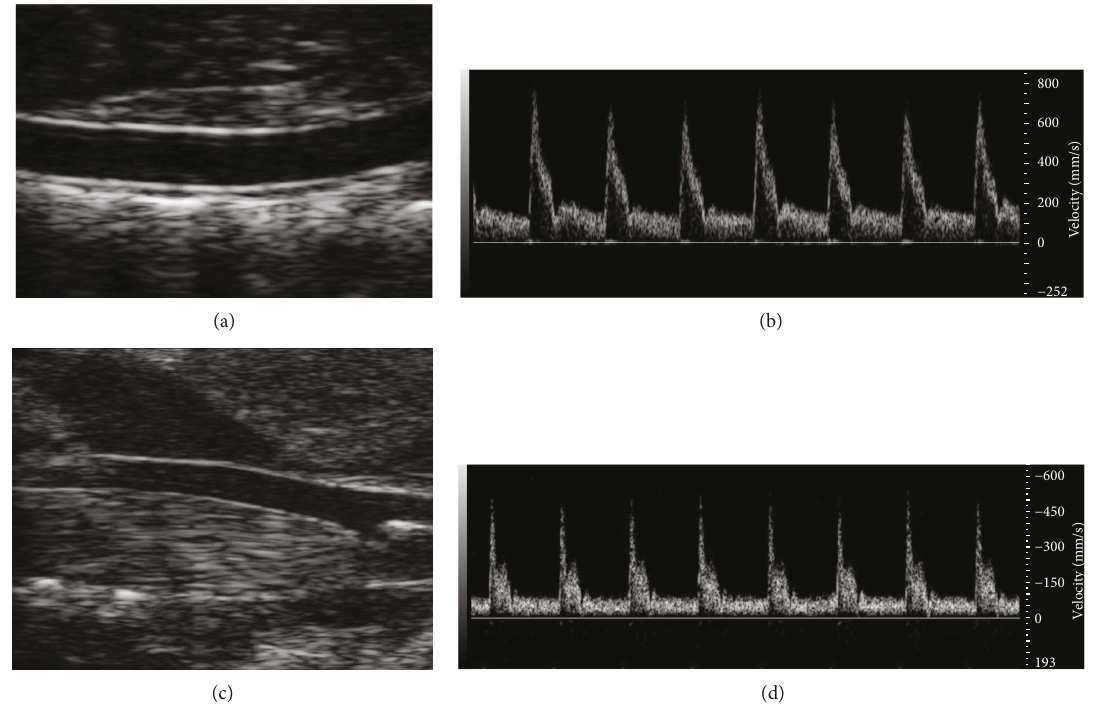
Figure 2: Abdominal aorta ultrasound scan. (a) B-mode image sequence was used to derived diameter and distension. (b) PW-Doppler signal was used to plot diameter- fl ow velocity loop thus evaluating PWV . Aortic pulse pressure was derived from PWV and distension abd abd measurements. Furthermore, blood fl ow velocity signal was used to derive wall shear rate measurements. Carotid artery ultrasound scan. (c) B-mode image sequence was used to derived diameter and distension. (d) PW-Doppler signal was used to plot diameter- fl ow velocity